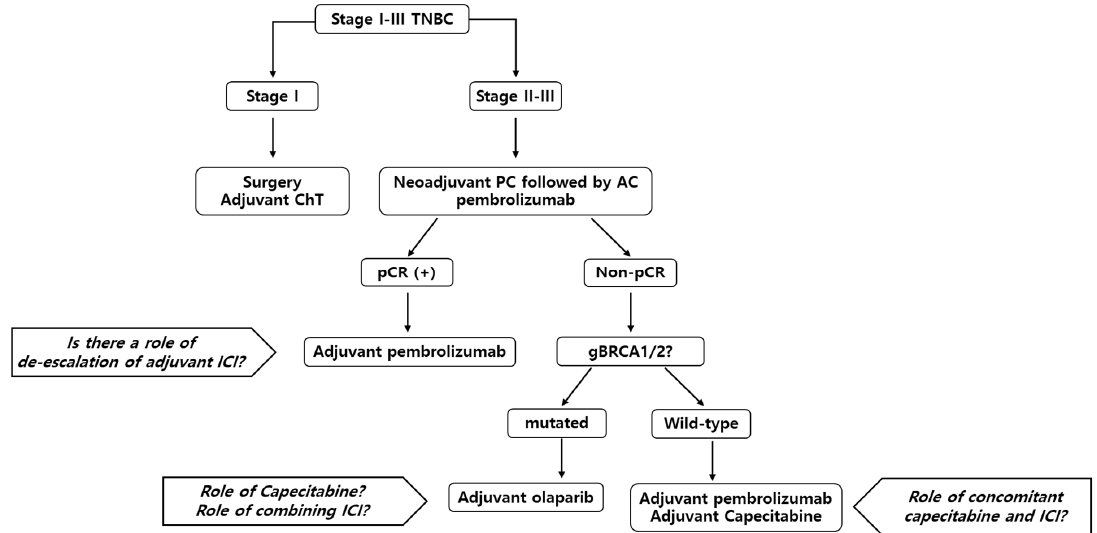
Figure 1. Suggested summarized systemic treatment flow for early TNBC patients. Abbreviations: TNBC, triple‑negative breast cancer; ChT, chemotherapy; PC, paclitaxel + carboplatin; AC, anthracy‑ cline + cyclophosphamide; pCR, pathologic complete response; gBRCA, germline breast cancer gene; ICI, immune checkpoint inhibitor.